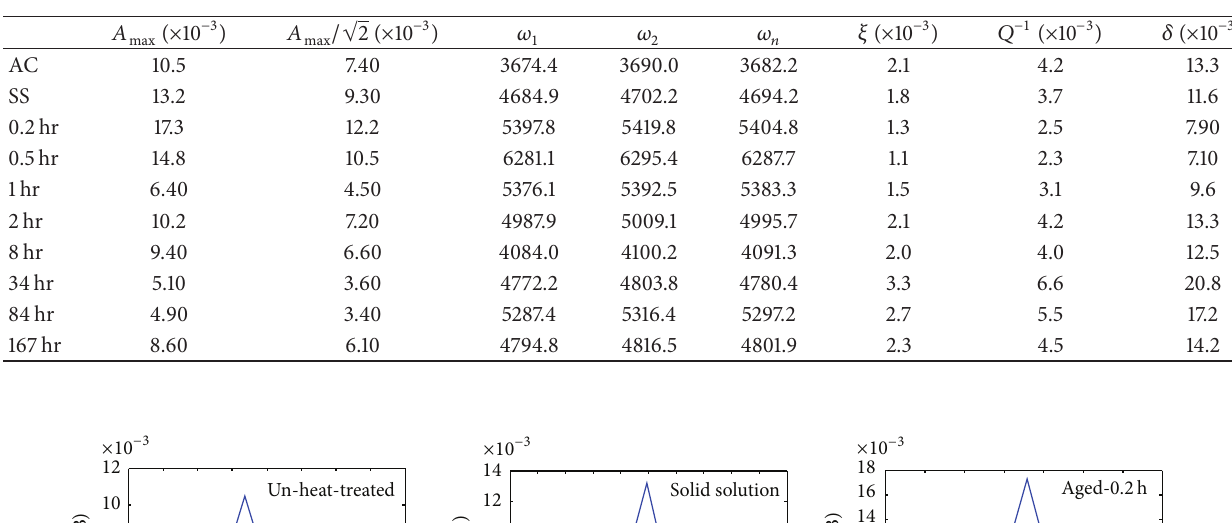
Table 2: Resonant frequencies of AZ61 alloy.